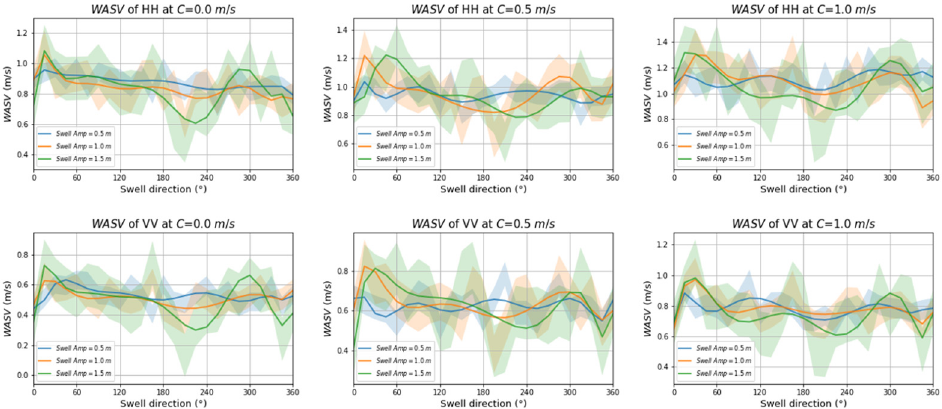
Figure 12. The relationship between WASV and swell direction for HH and VV polarizations and for different current velocities and swell amplitudes. Wind direction and speed were 0 ◦ and 10 m/s, respectively. Swell wavelength was 200 m. Other input parameters were set to the values indicated in Table 1. The swell amplitude is indicated by color: blue indicates amplitude of 0.5 m, yellow indicates amplitude of 1.0 m, and green indicates amplitude of 1.5 m. Solid line indicates mean values. Shaded areas indicate ±1 standard deviation of the median.